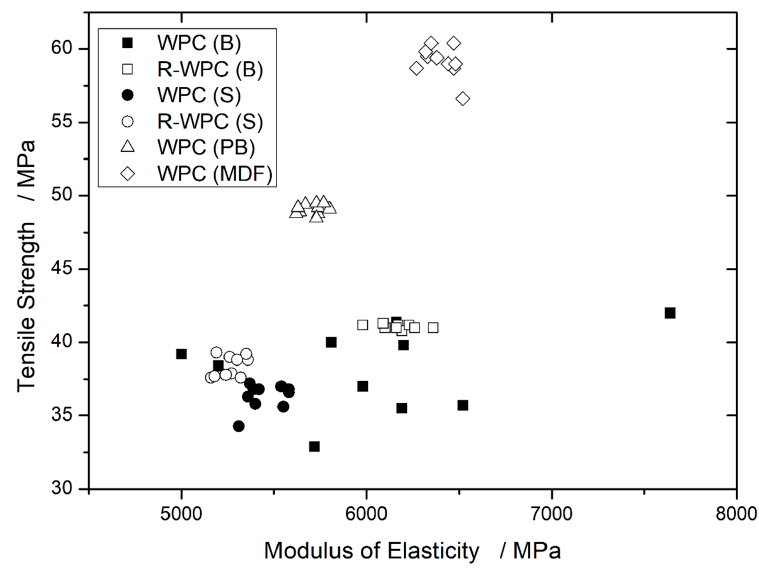
Figure 3. Tensile strength and modulus of elasticity of injection moulded specimens of reinforced polypropylene composites using various particle sources. Tensile strength is plotted as a function of modulus of